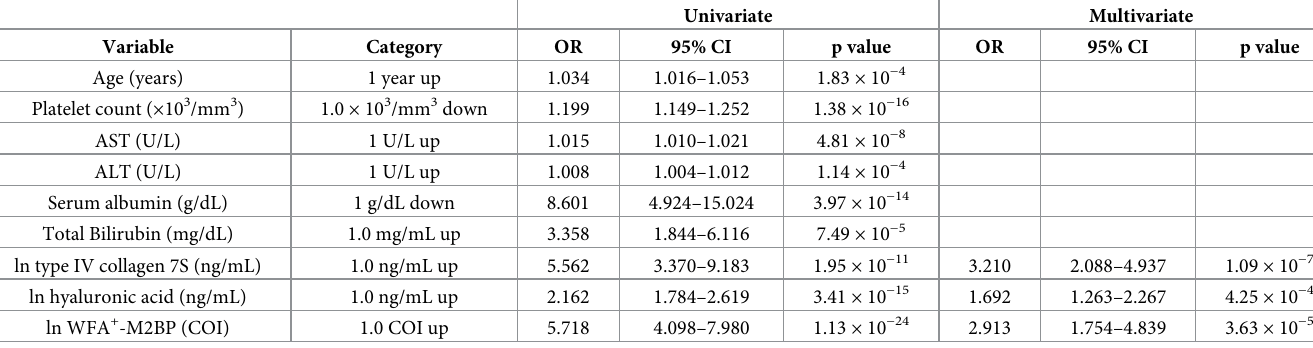
Table 2. Analysis of factors associated with liver stiffness measurement � 12.5 kPa (liver cirrhosis).